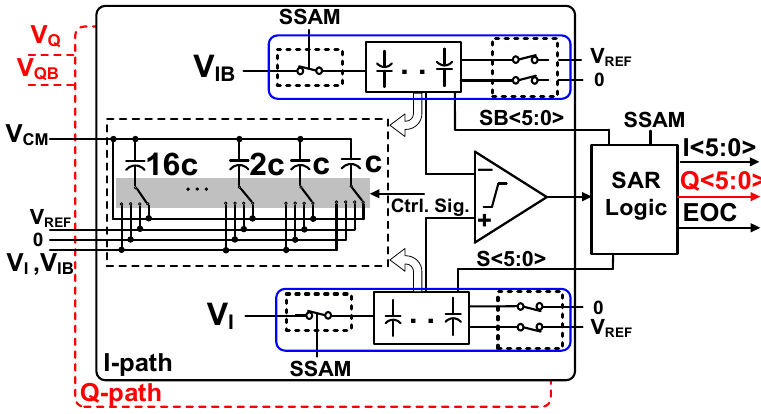
Figure 12. Block diagram of proposed fully di ff erential SAR